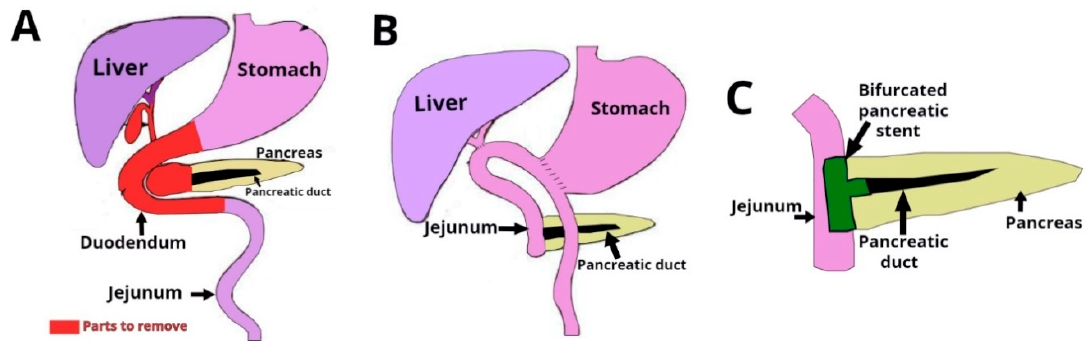
Figure 2. Pancreaticoduodenectomy (PD) or Whipple is a surgical procedure performed to remove cancerous tumors from the pancreas. The technique consists of the extirpation of a section of the stomach, the first and second portions of duodenum, the head of the head of the pancreas, the common bile duct, and the gallbladder.